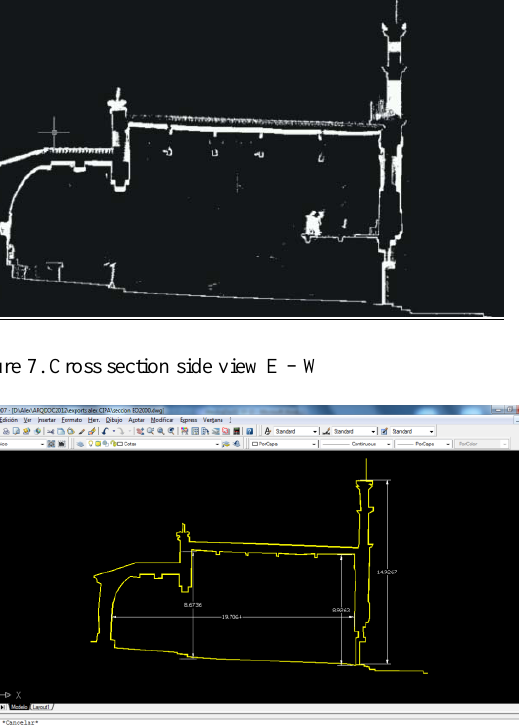
Figure 8. Cross section side view E – W in a CAD system.